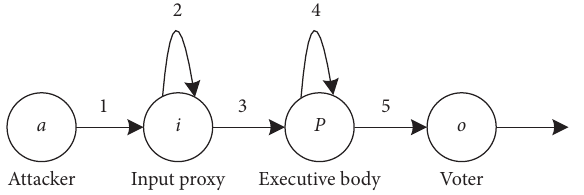
Figure 6: single redundancy mimic defence system security analysis model.